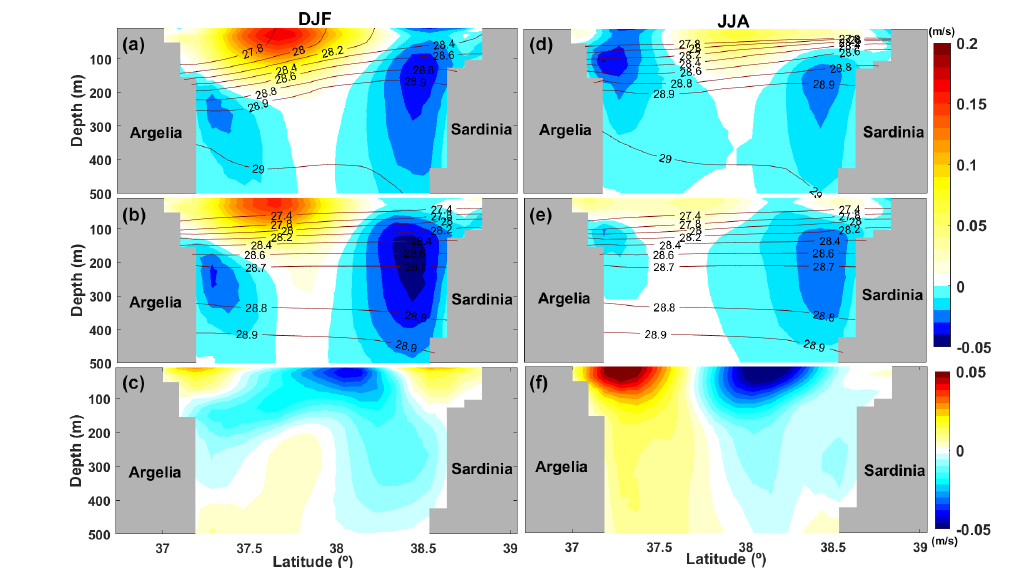
Figure 4. Winter (a–c) and summer (d–f) vertical cross sections of current velocity across the Sardinia Strait (36.73 ◦ N, 8.04 ◦ E to 39.04 ◦ N, 8.79 ◦ E; see Fig. 1), in ms − 1 , for present (a, d) and future (b, e) climate as computed from ROM. Positive values indicate eastward flow and negative values the opposite. Isopycnals are also depicted. Differences between ocean current velocities in the future and present climate are shown in panels (c, f) . Note that only the upper 500m of the water column are shown for a more detailed visualization of surface velocities.